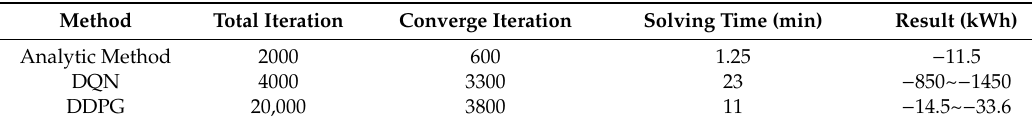
Table 2. The solving ability of analytic method, DQN,